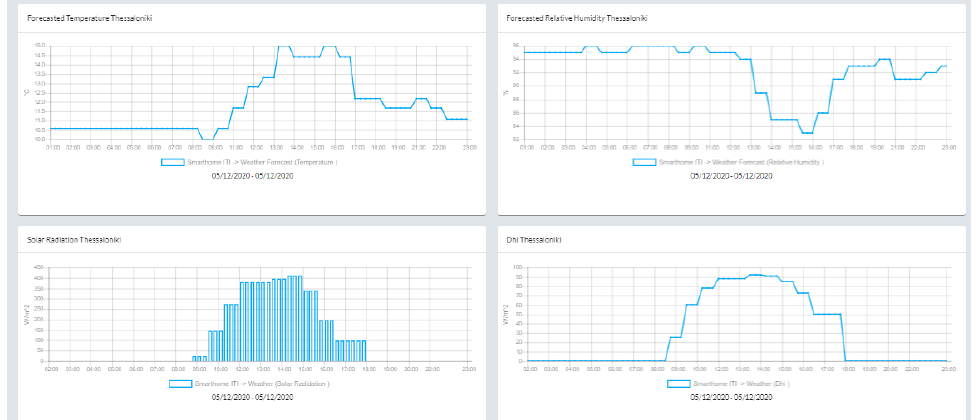
Figure 12. Weather forecasting tool monitoring and real-time visualization to the UI.